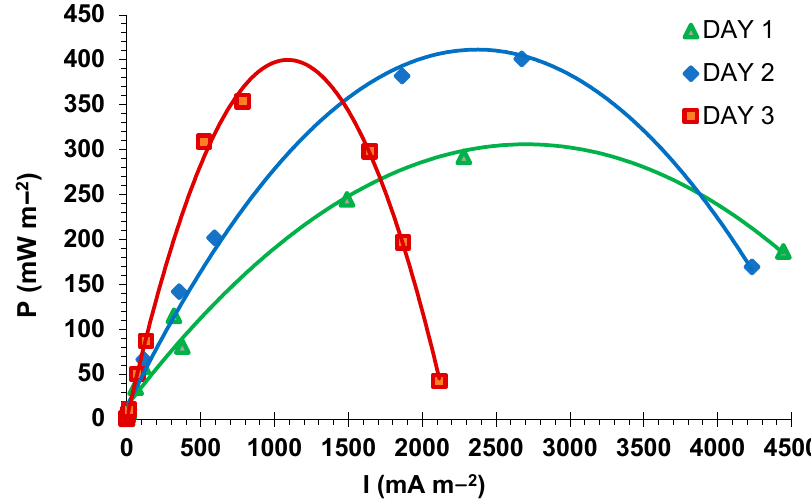
Figure 7. Power density curves depending on current density per day during the MFC functioning with the ZrP 2 O 7 catalyst.